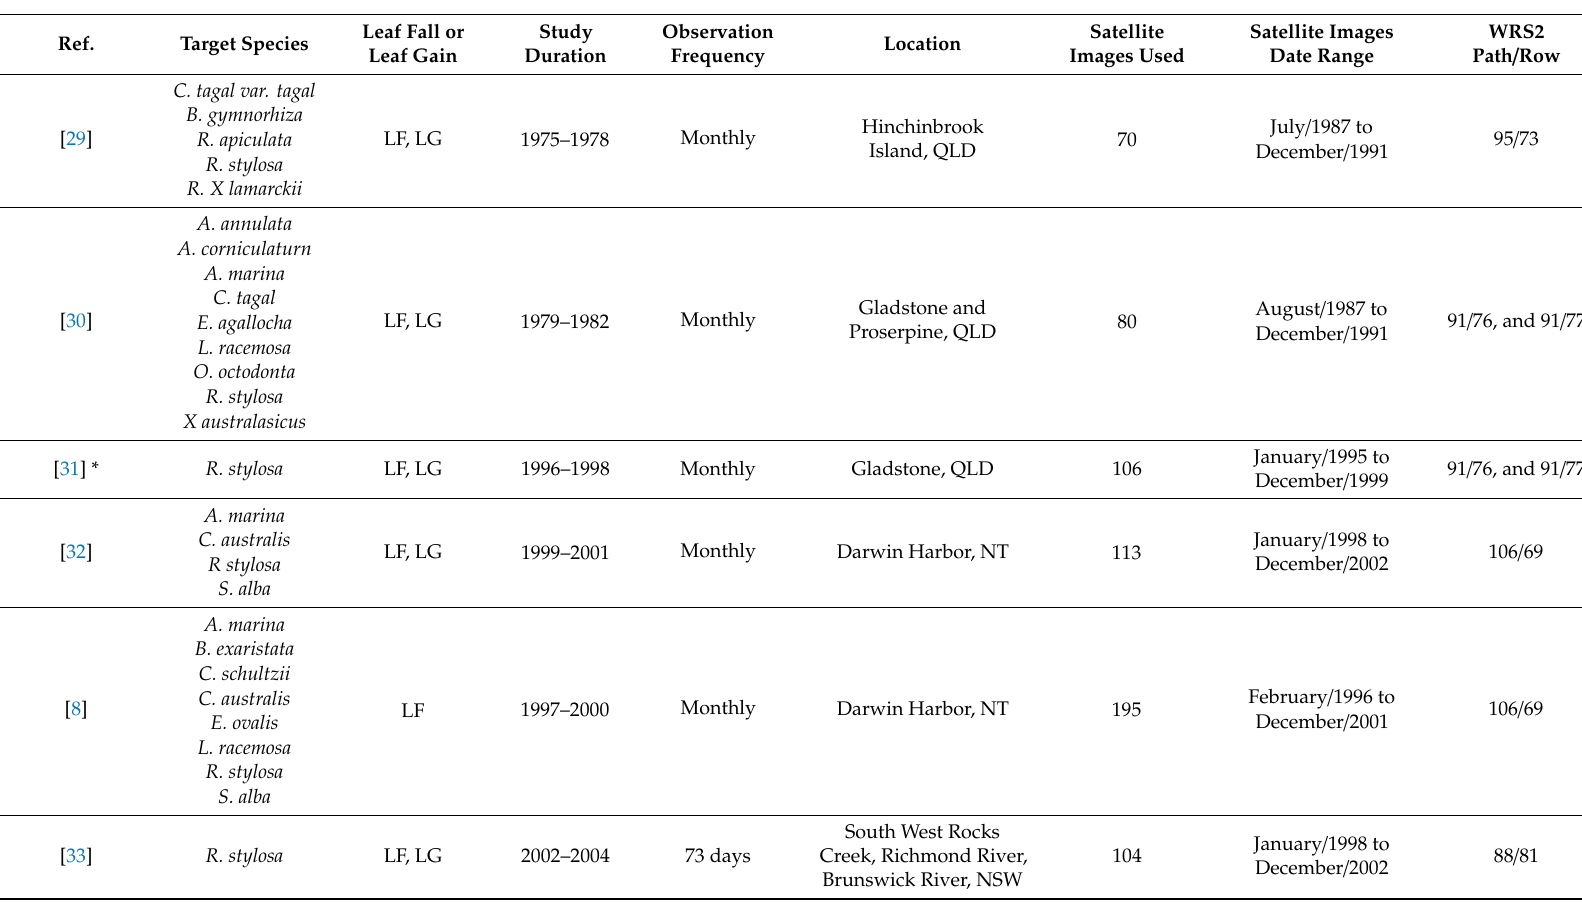
Table 1. Peer-reviewed studies used for the qualitative comparison: target species, study duration, location and description of satellite images used.